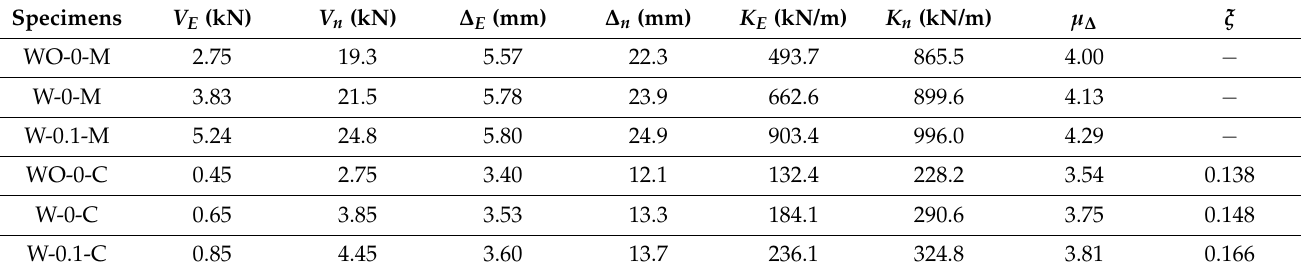
Table 4. Summary of test results subjected to shear